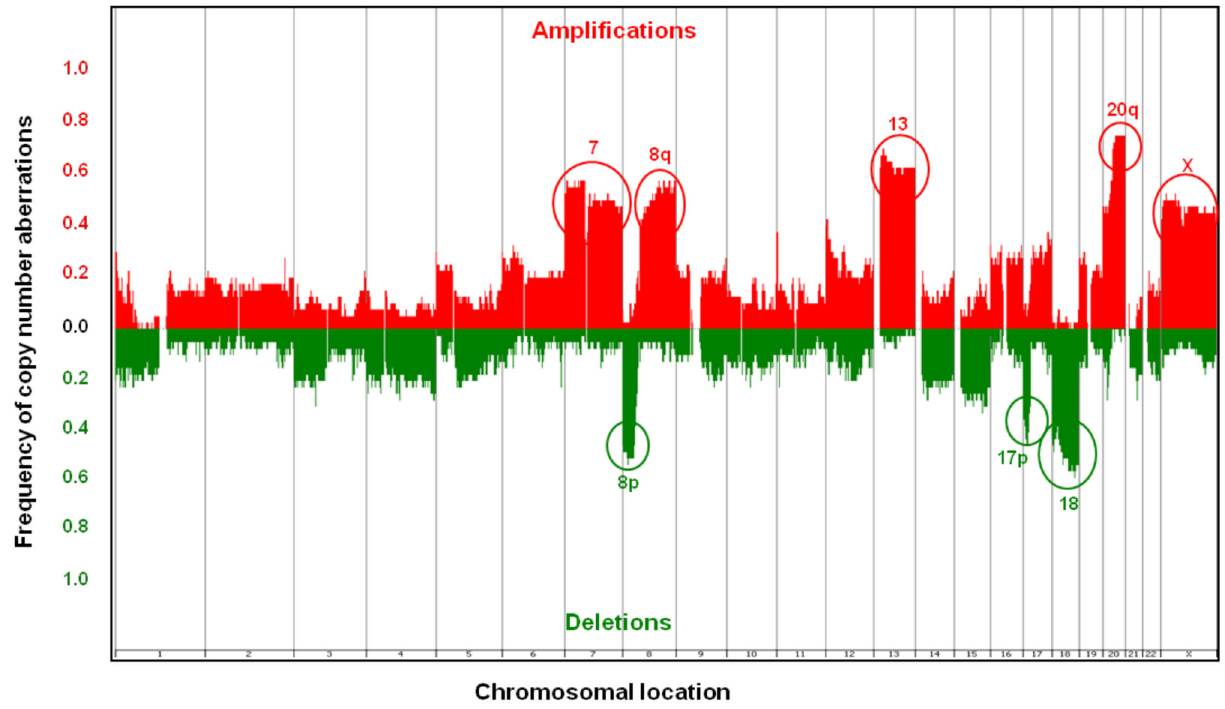
Figure 1. Distribution of CNA in 40 CIN tumour samples. Data from the 180K format array are shown. Red represents gains and green represents deletions. The y-axis reflects